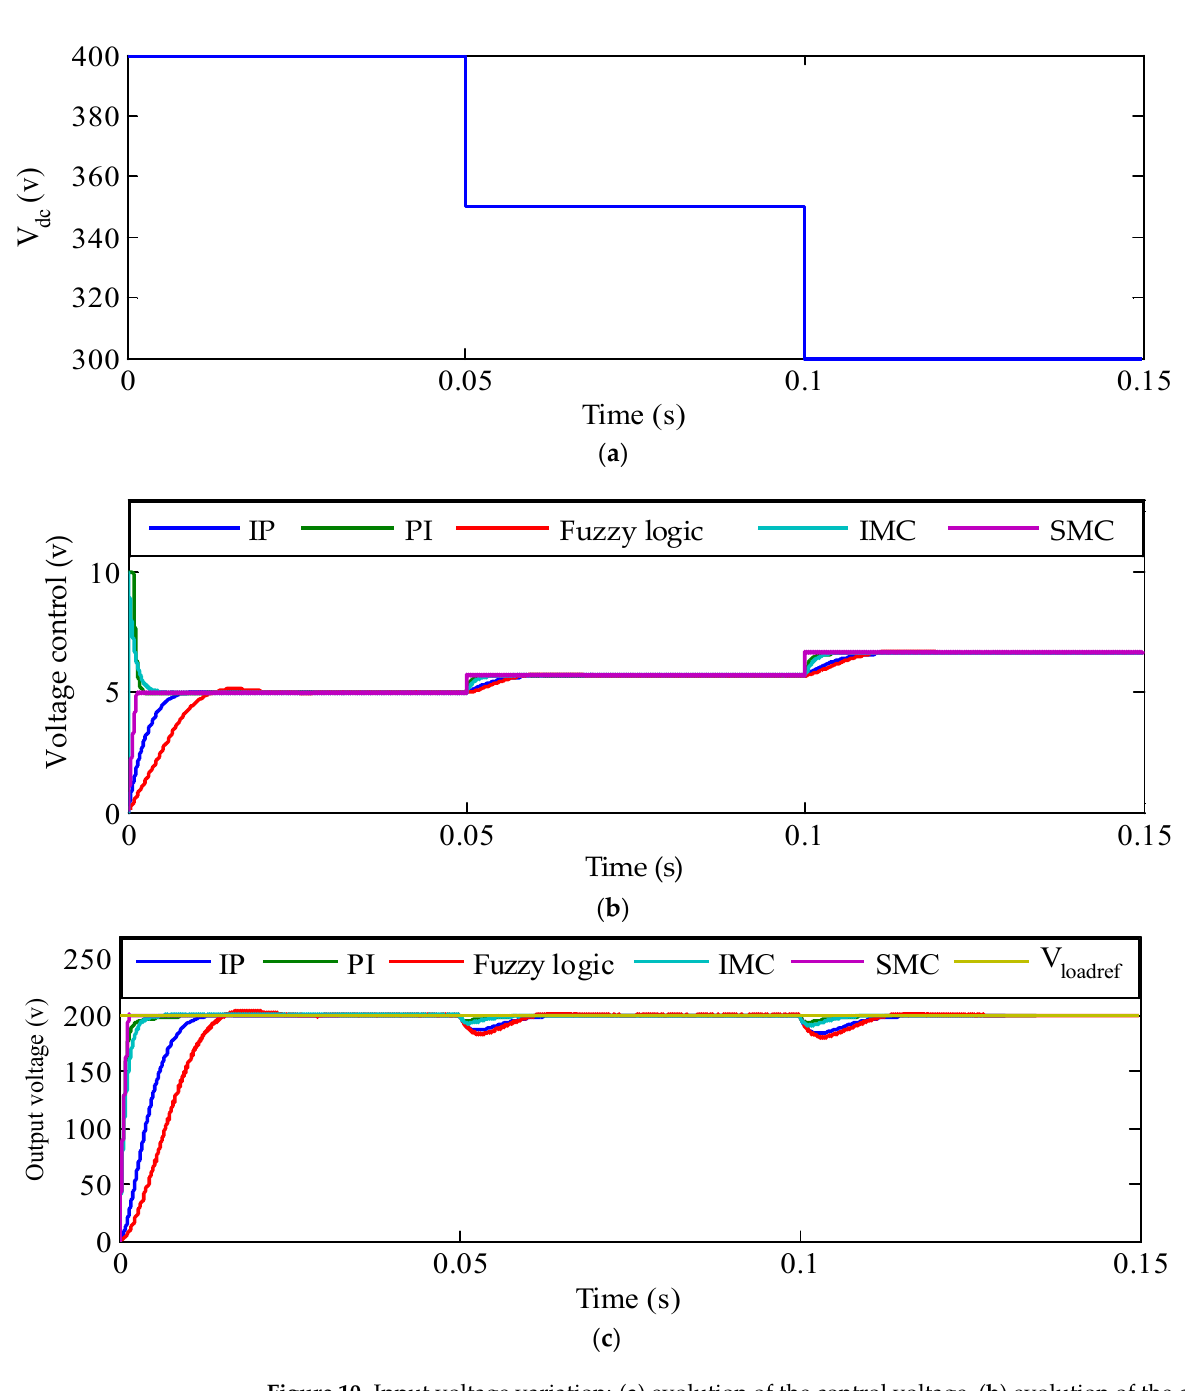
17 of 22 ( b ) Figure 9. Triangular target output voltage variation: ( a ) evolution of the control voltage and ( b ) evolution of the output voltages. 6.4. Controller’s Behavior under Input Voltage Variations